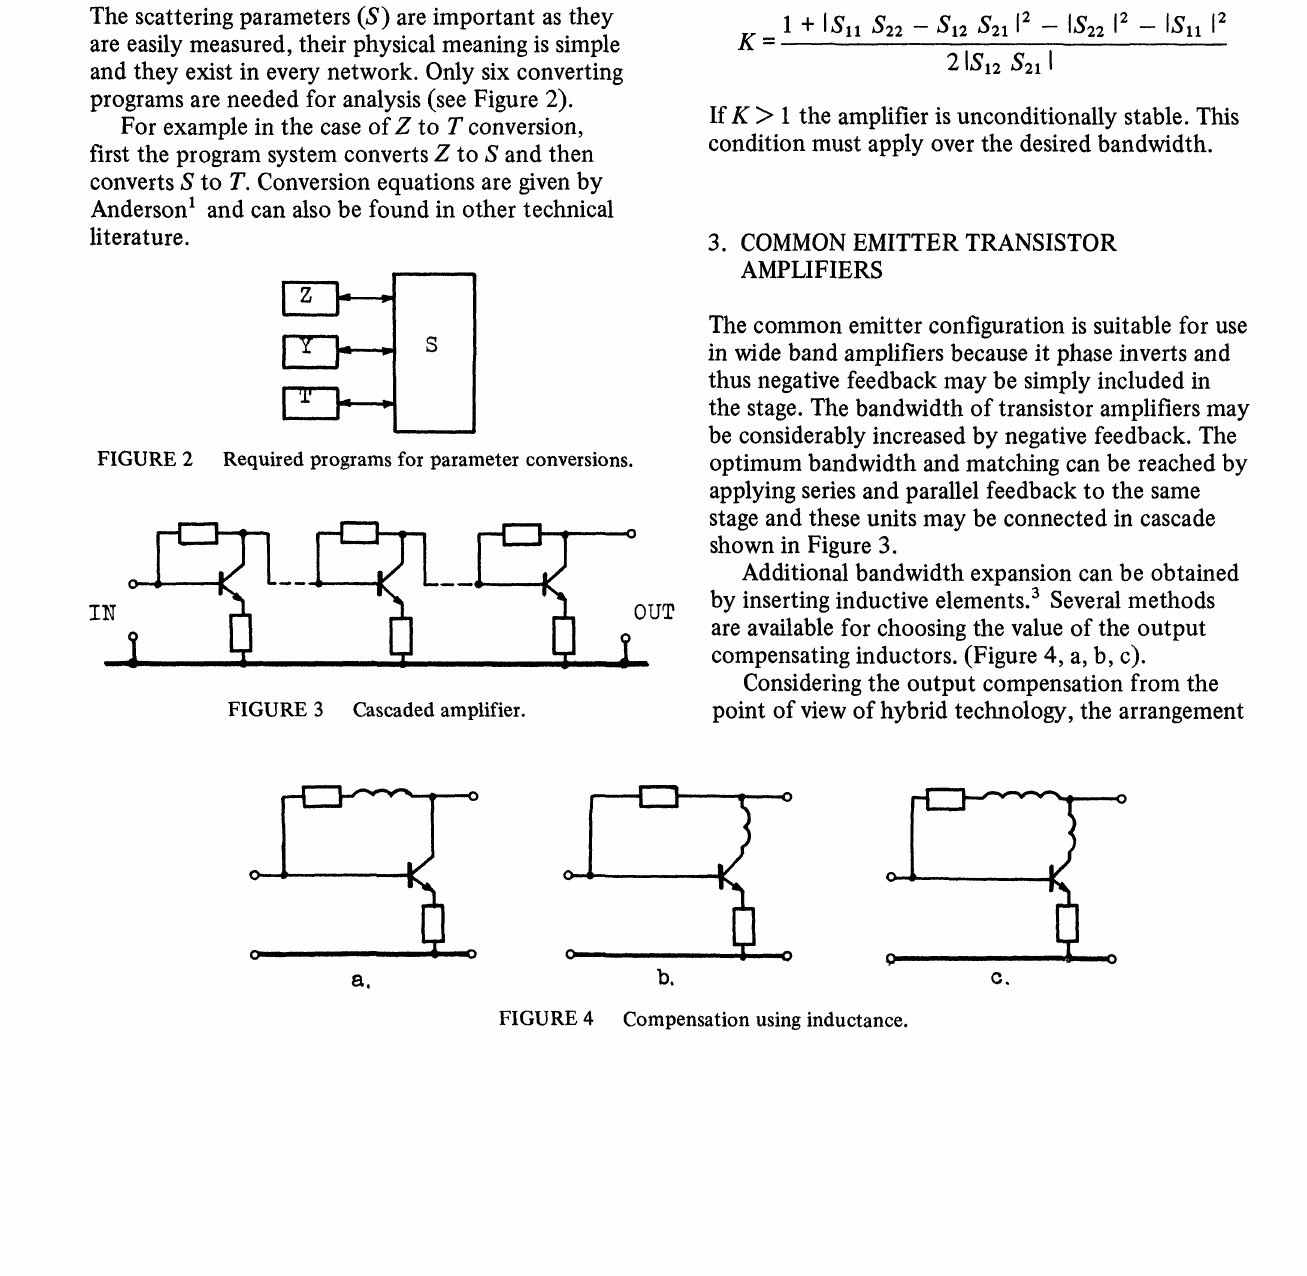
Compensation using